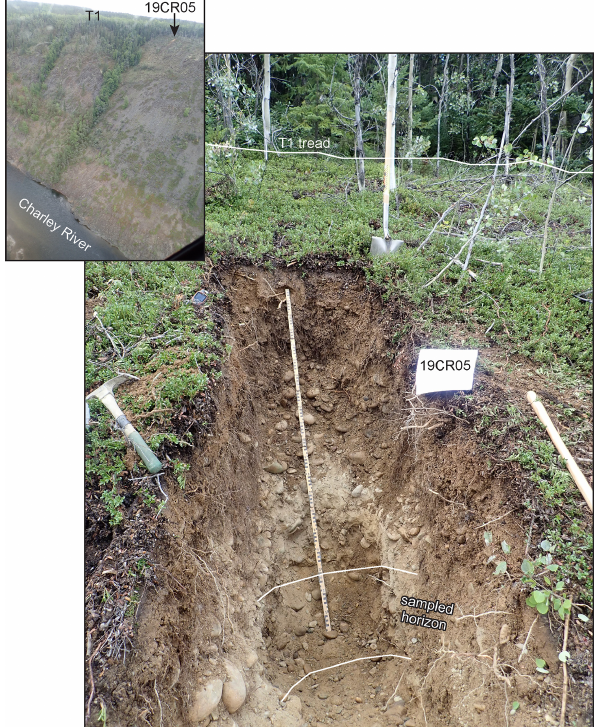
Figure A3. Cosmogenic isochron burial age sample site 19CR05. Site located on Charley River high terrace (T1) in Alaska near the Charley–Yukon River confluence. Inset aerial photo is taken looking southwest; Charley River flow is to the right. Photographs by the US Geological